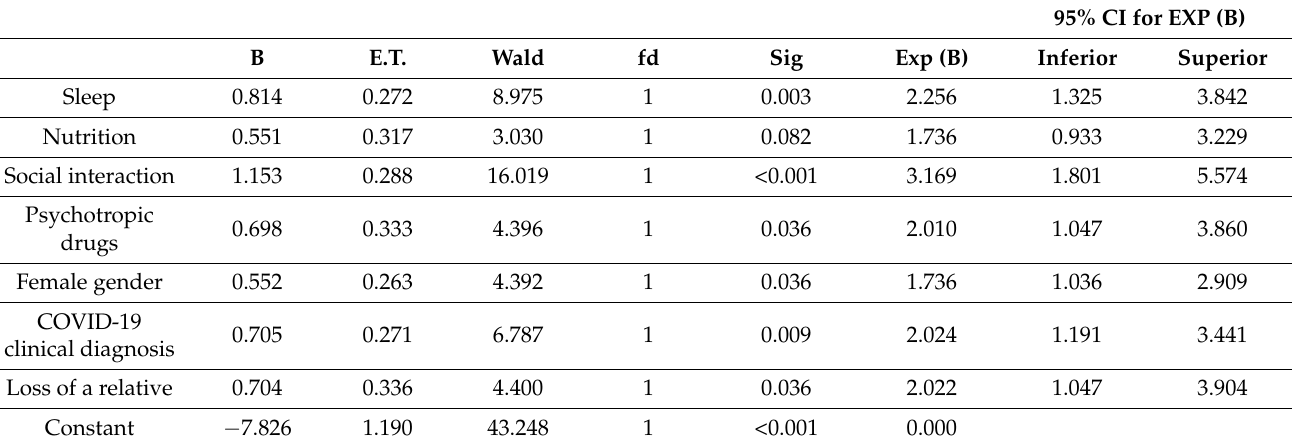
Table 3. Logistic regression